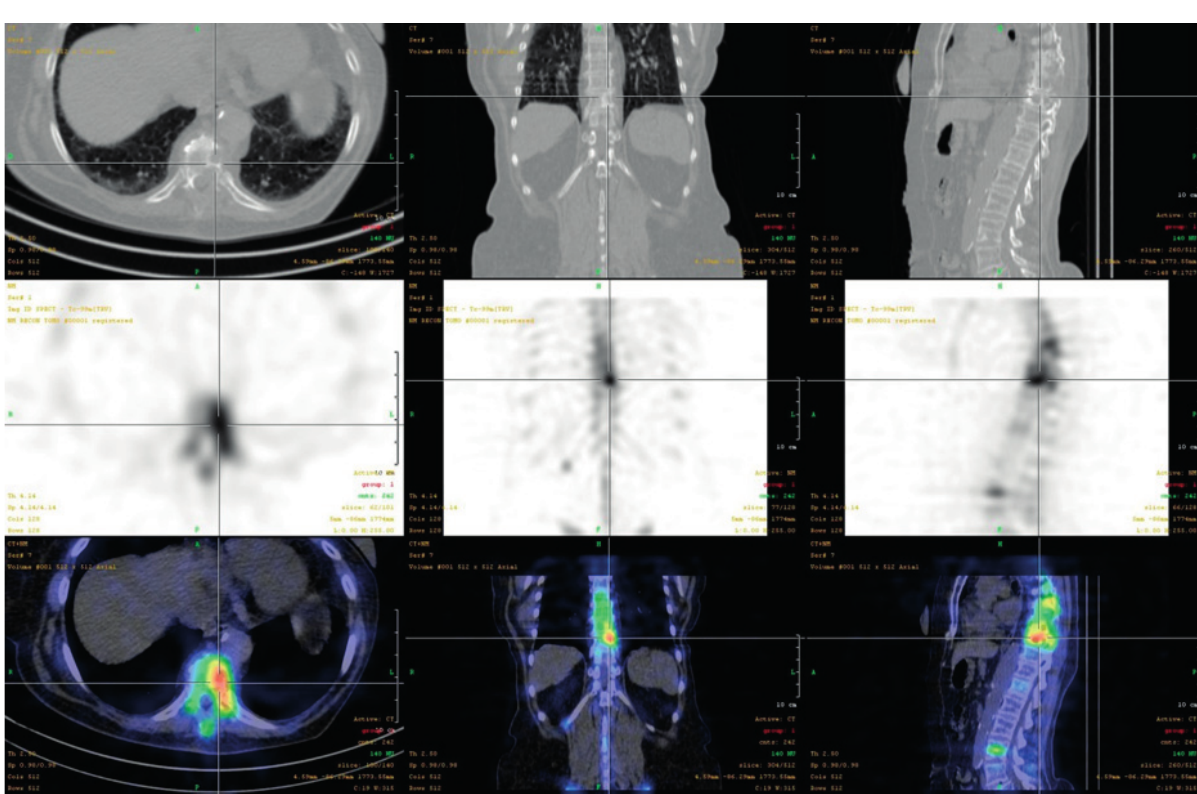
Fig. 1. Breast cancer with mixed bone metastases (top CTscan, centre SPECT scan, bottom fused SPECT/CT